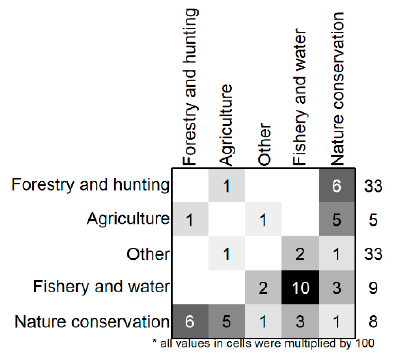
Figure 3. The matrix of conflicts among sectors in the participatory process of the formulation of PUN.